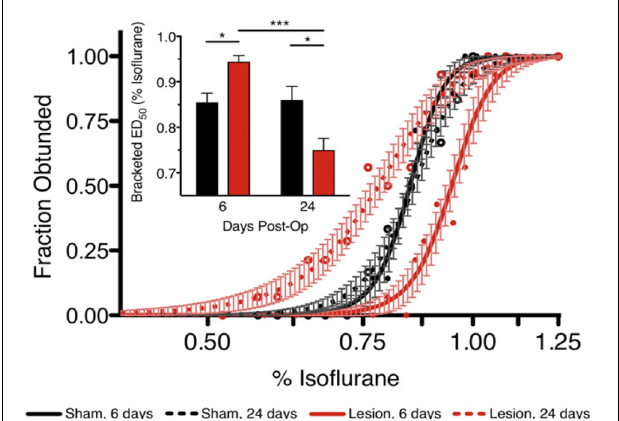
FIGURE 5 | Ventrolateral preoptic nucleus is not necessary for anesthetic-induced unconsciousness. Lesions of the ventrolateral preoptic nucleus reveal an acute effect of resistance but a chronic effect of hypersensitivity to the inhaled anesthetic isoflurane. Reproduced from Moore et al. (2012), Current Biology, with permission. ∗ p < 0 . 05; ∗∗∗ p < 0 .